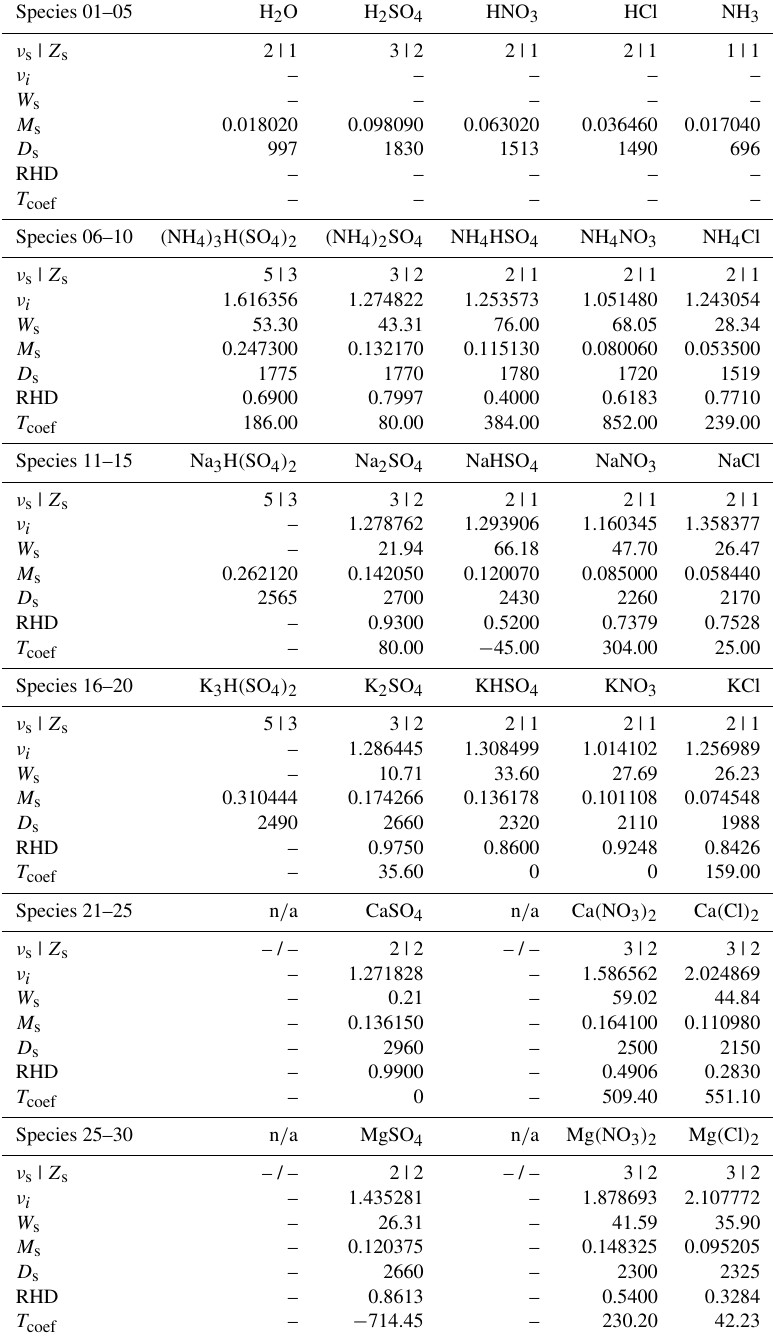
Table 1. Thermodynamic data (Sect. 2.1): stoichiometric coefficient ν s [−] , the ion-pair charge Z s [−] , the single solute parameter ν i [−] , the mass fraction solubility in percent W s [ % ] ( w s = W s / 100), the molar masses M s [ kgmol − 1 ] , the densities D s [ kgm − 3 ] , RHD( T o ) [−] at reference temperature T o = 298.15 [ K ] , and the corresponding temperature coefficients, T coef(RHD) [−] . The ν i values have been obtained from the RHD and W s values (at T o = 298 [ K ] ) following the method described in Metzger et al. (2012). The RHD values are taken from Fountoukis and Nenes (2007); the W s and all other values are taken from the Handbook of Chemistry and Physics (Lide,